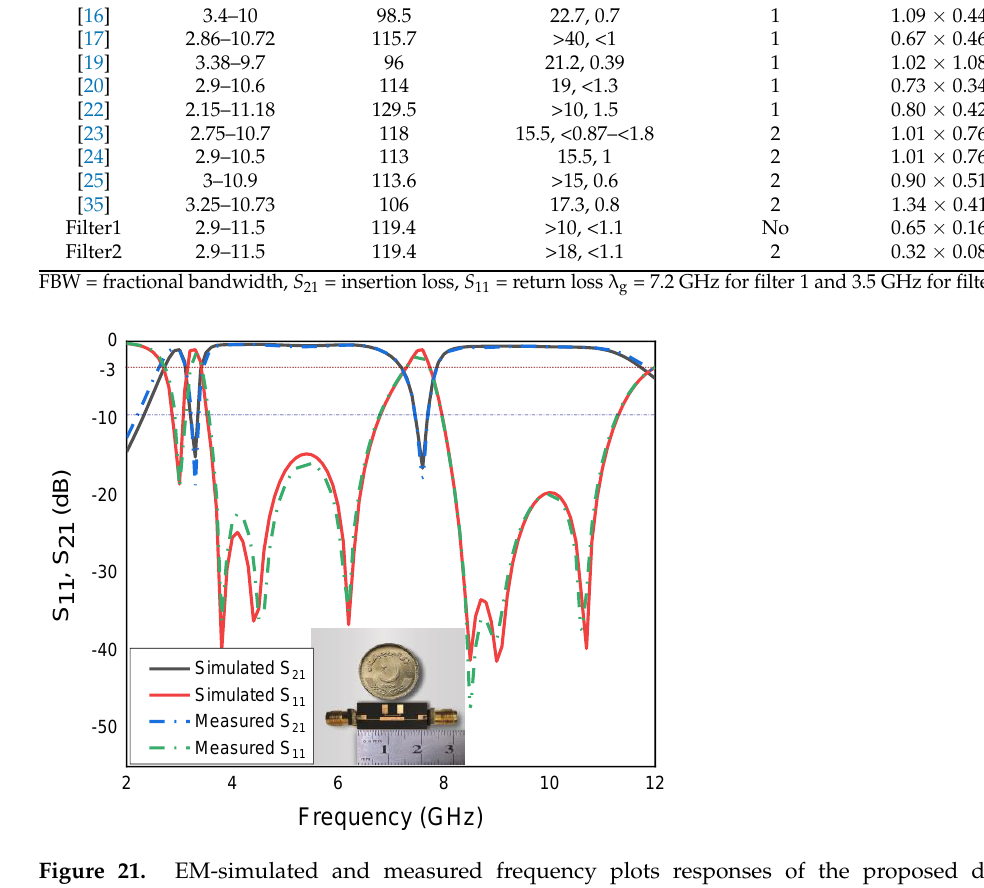
Table 2. Comparison with other reported work.